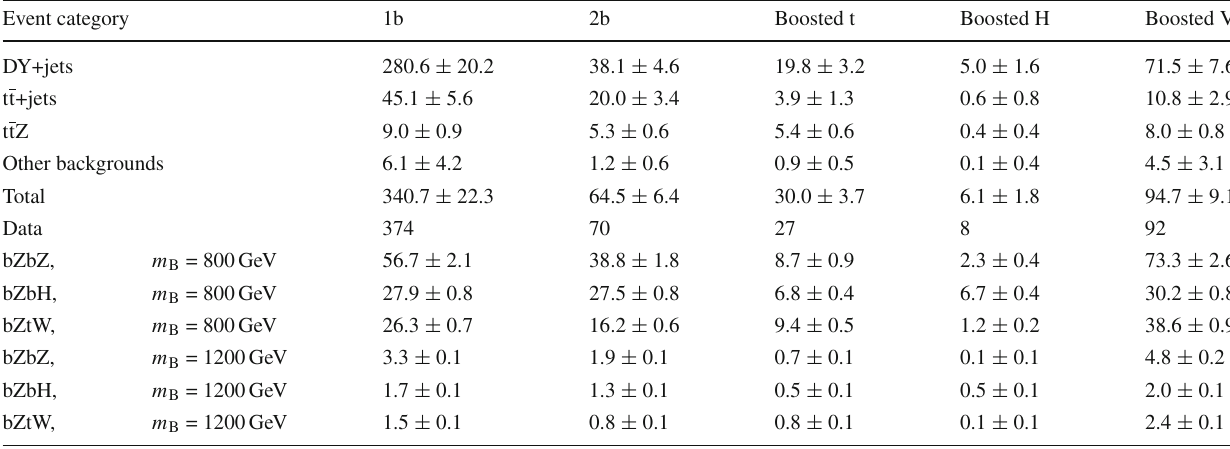
Table 9 The number of observed events and the predicted number of SM background events in the BB search for the five event categories using Z → μ + μ − channel. The expected numbers of signal events for B masses of 800 and 1200GeV with branching fraction hypotheses for the three decay channels, B ( B → bZ ) = 100% (bZbZ), B ( B → bZ ) =